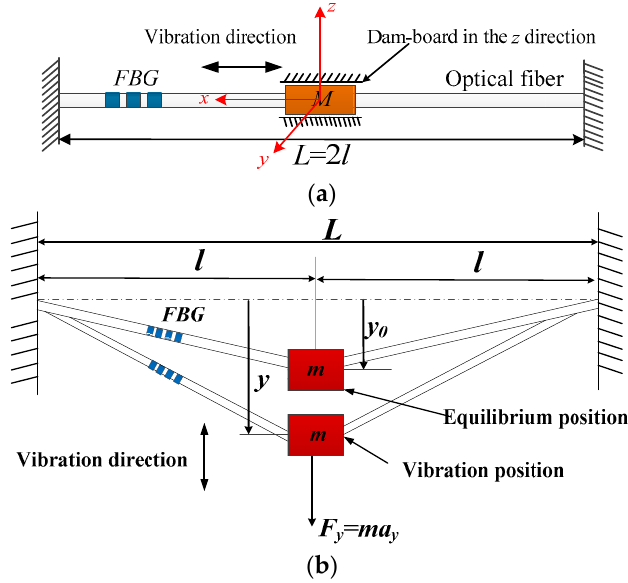
Figure 1. Vibration model of a bare optical fiber with FBG and lumped mass. ( a ) Horizontal vibration model of a bare optical fiber with FBG and lumped mass; ( b ) Vertical vibration model of a bare optical fiber with FBG and lumped mass.